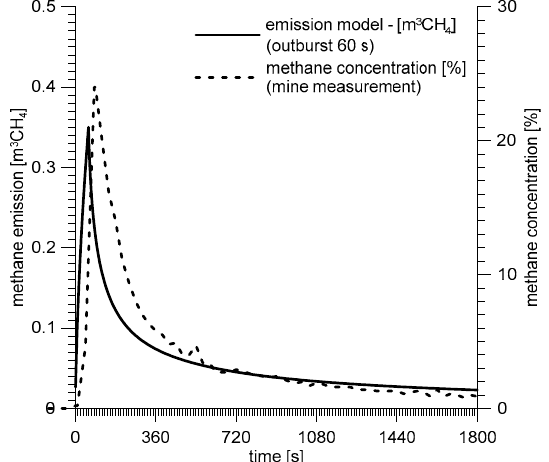
Figure 24. Methane concentration in the excavation after the Zofiówka outburst juxtaposed with the model methane emission.